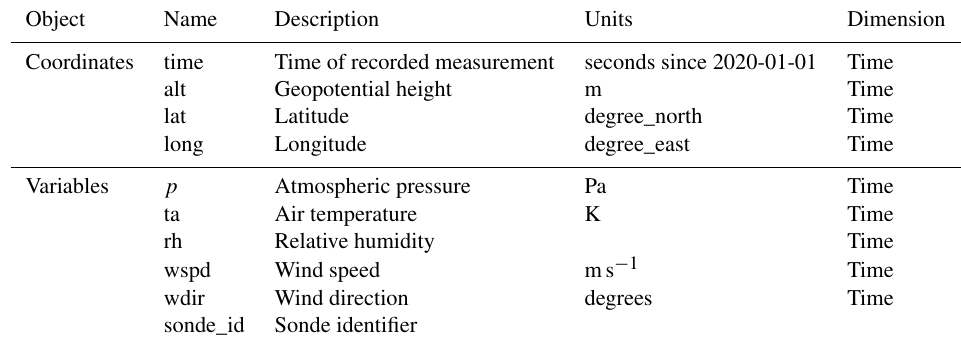
Table 7. Table shows the structure for the Level-2 product, outlining the coordinates and variables and their corresponding descriptions, units and